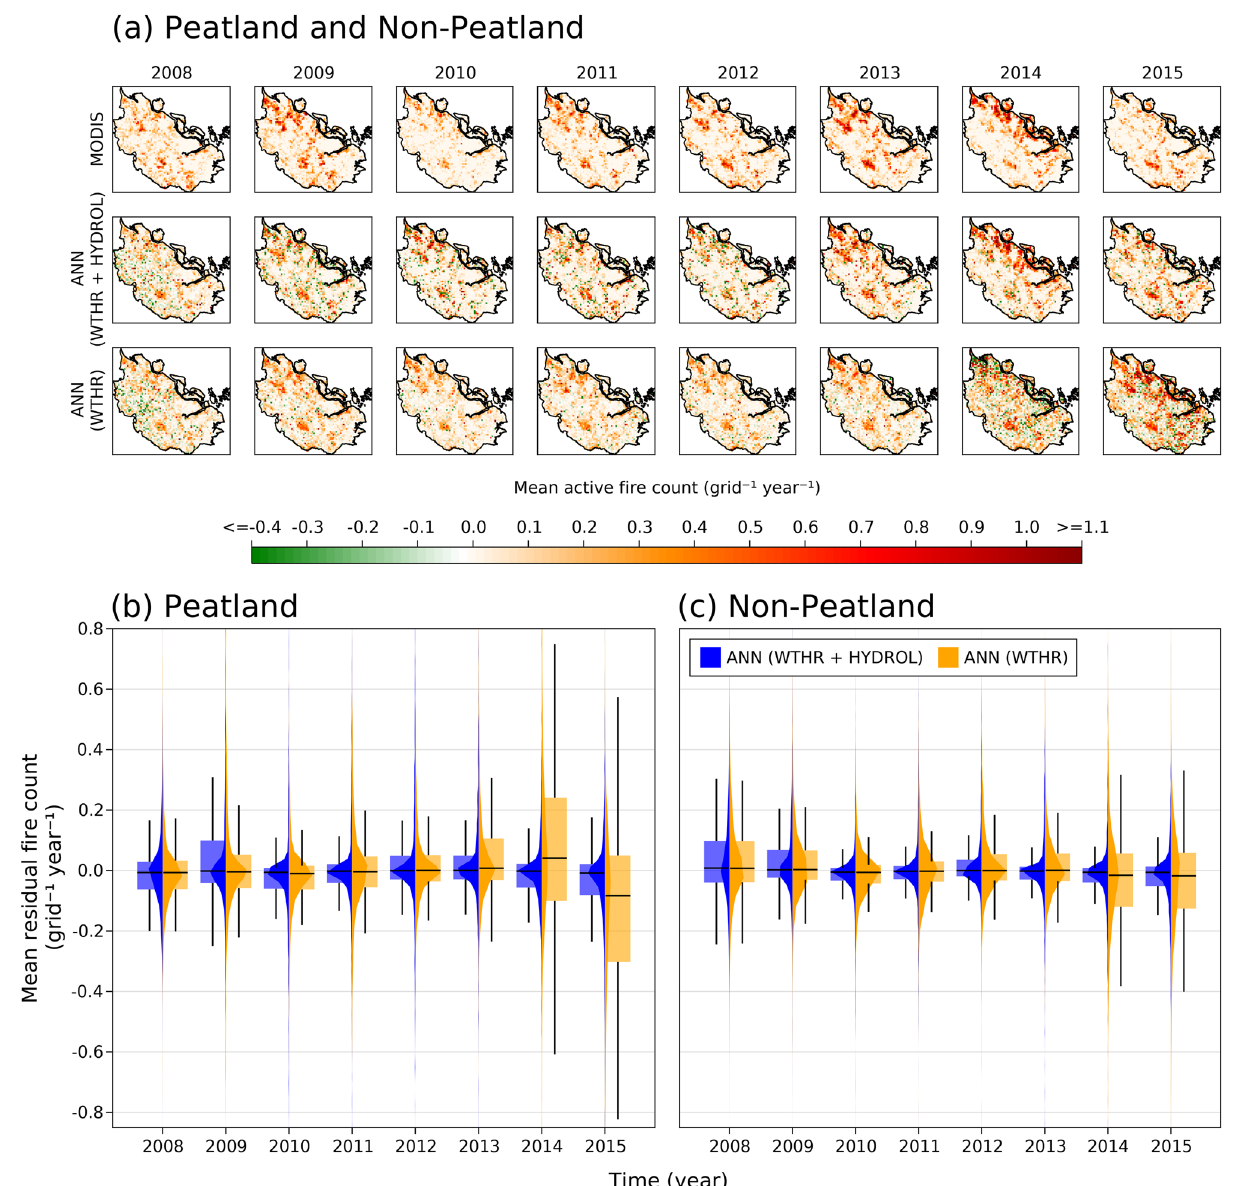
Figure 4. Spatial distribution of active tropical peatland and non-peatland fires. ( a ) Mean annual Moderate Resolution Imaging Spectroradiometer (MODIS), and artificial neural network (ANN) predicted active fire count during 2008–2015 for each grid across Riau province, Sumatra, Indonesia. Distribution of mean annual residual fire count (= MODIS—predicted) over ( b ) peatland and ( c ) non-peatland grids as depicted in vertical probability distribution plots and paired box and whisker plots. ANN (WTHR + HYDROL) = ANN model featured by both weather and hydrology variables, ANN (WTHR) = ANN model featured by only weather variables. The maps in ( a ) were created by using Julia Programming Language version 1.6.7 (https:// julia lang. org/ downl